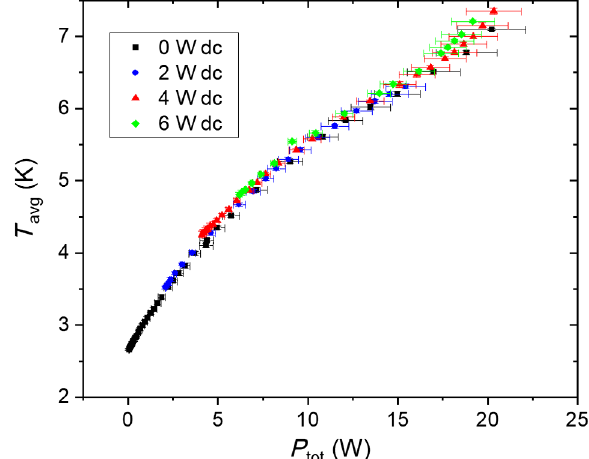
FIG. 26. T as a function of the total heat load, avg ¼ P þ P P , for different values of P tot rf dc P , P was increased up to the thermal stability limit, except dc rf ¼ 2 W. for P dc